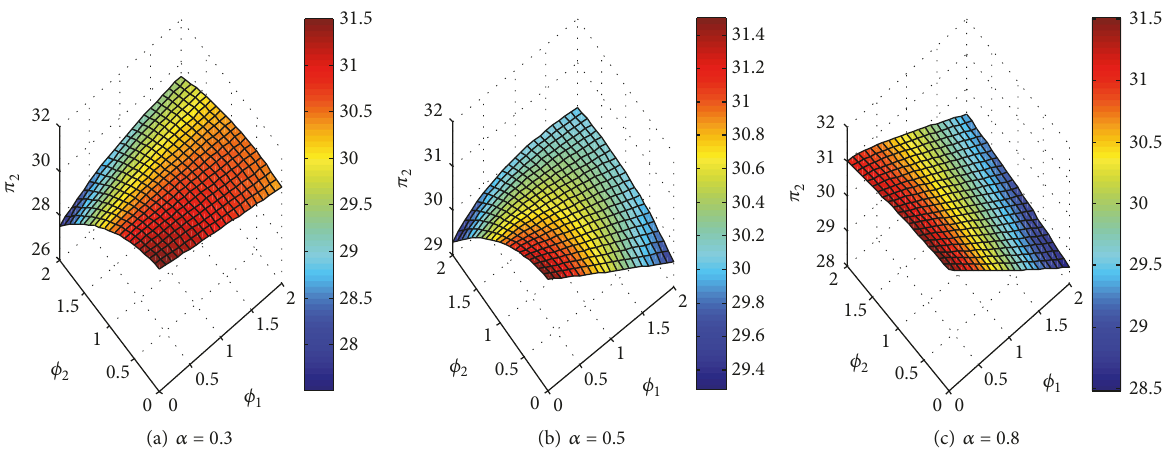
Figure 7: The impact of fairness concern on player 2’s expected profit 𝜋 2